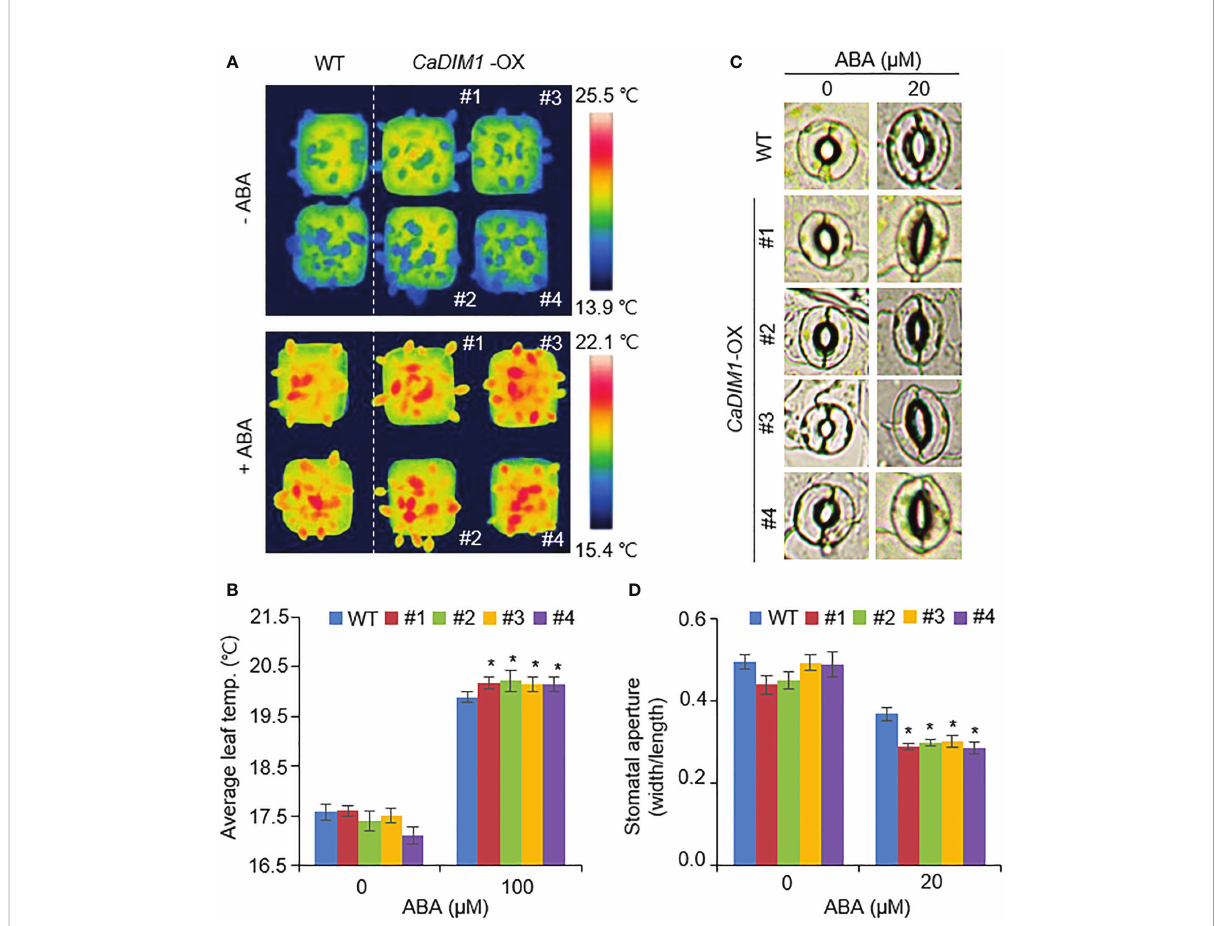
FIGURE 5 Enhanced ABA sensitivity of CaDIM1 -overexpressing (OX) transgenic Arabidopsis plants. (A, B) Leaf temperatures of wild-type and CaDIM1 -OX transgenic plants after exposure to 100 m M abscisic acid (ABA). At 6 h after treatment, representative thermographic images were taken (A) and leaf temperature was measured (B) . (C, D) Stomatal aperture in wild-type and CaDIM1 -OX plants treated with ABA. Leaf peels were harvested from 3-week-old plants of each line and incubated in stomatal opening solution containing the indicated concentrations of ABA. Representative images were taken under a microscope, (C) and the stomatal aperture was measured (D) . All data represent the mean ± standard error of three independent experiments. Asterisks indicate signi fi cant differences between wild-type and CaDIM1- OX plants (Student ’ s t -test; * P <